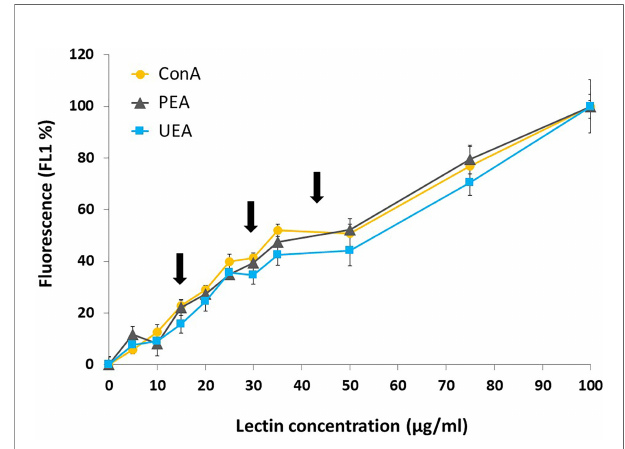
FIGURE 1 | Fluorescence intensity (mean ± standard deviation, 3 biological replicates per data point) of Chlamydomonas sp. labeled with several concentrations of FITC-lectins (ConA, PEA and UEA, up to 100 µg/ ml). Black arrows indicate concentrations (15, 30 and 45 µg/ml) used in feeding experiments.